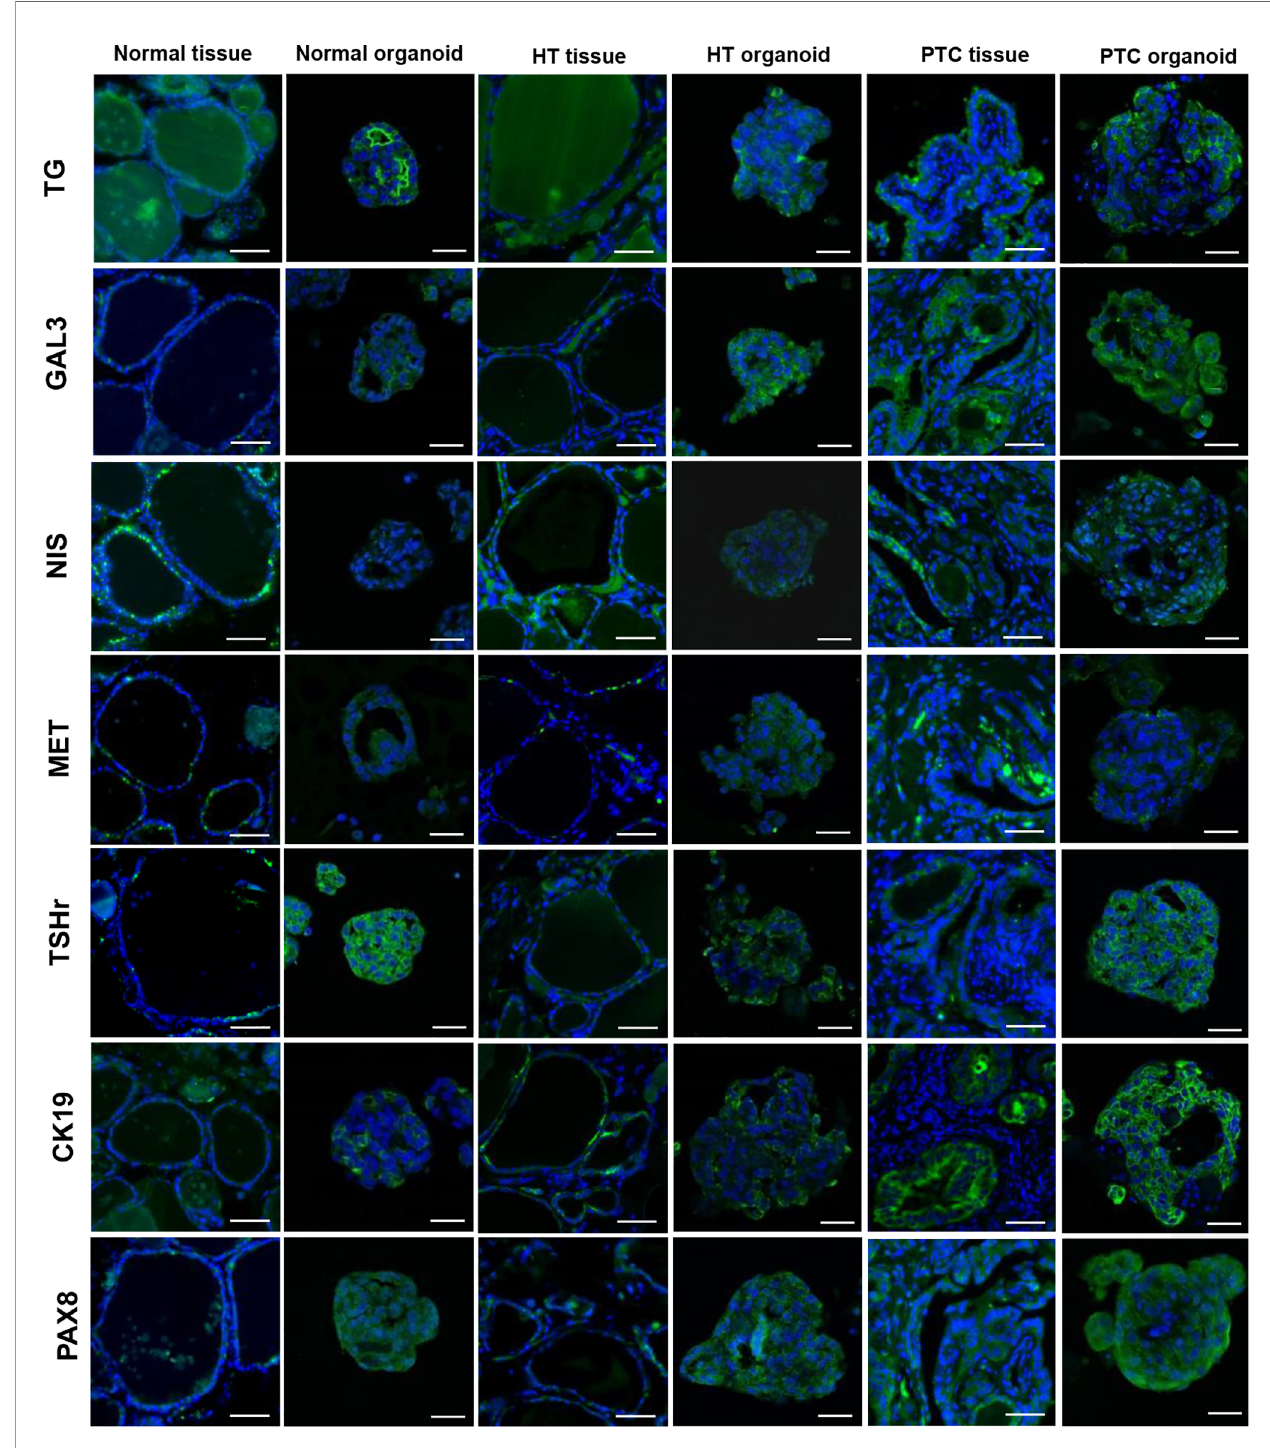
FIGURE 5 | Representative images of thyroids organoids subjected to immuno fl uorescence analysis for thyroid-speci fi c markers, papillary thyroid carcinoma (PTC) markers. Organoids were cultured for 15 days before fi xation and staining with Alexa-488 phalloidin and 4 ′ ,6-diamidino-2-phenylindole (DAPI). Scale bars, tissues = 50 µm, organoid = 20 µm. Markers indicated on the left side are shown as a green fl uorescent signal. Nuclei are shown as a blue fl uorescent